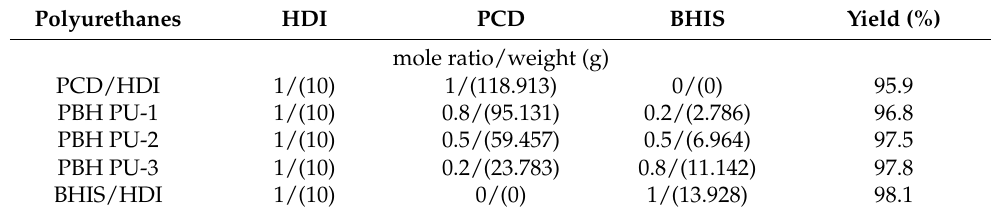
Table 1. Polyurethane series with different PCD and contents.